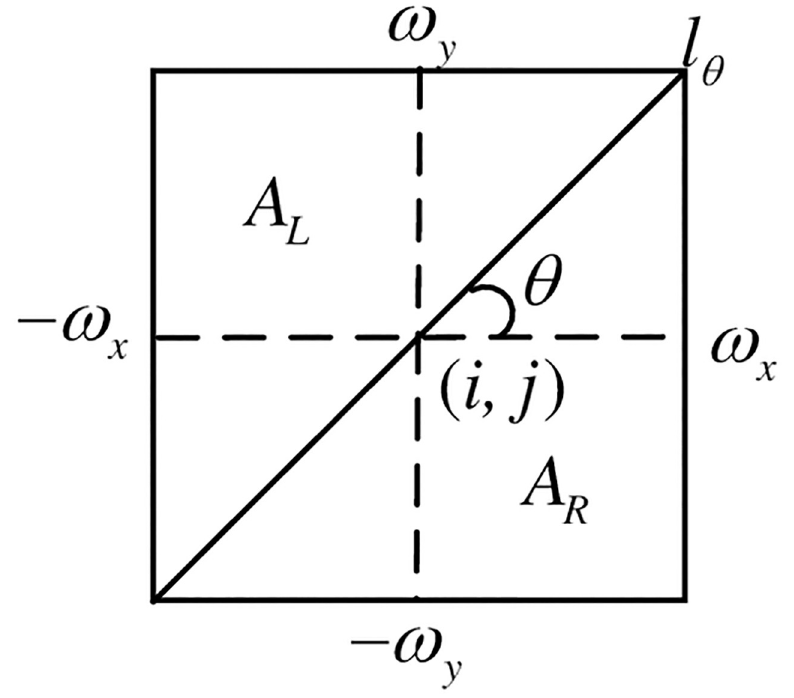
Fig 5. Schematic calculation of direction